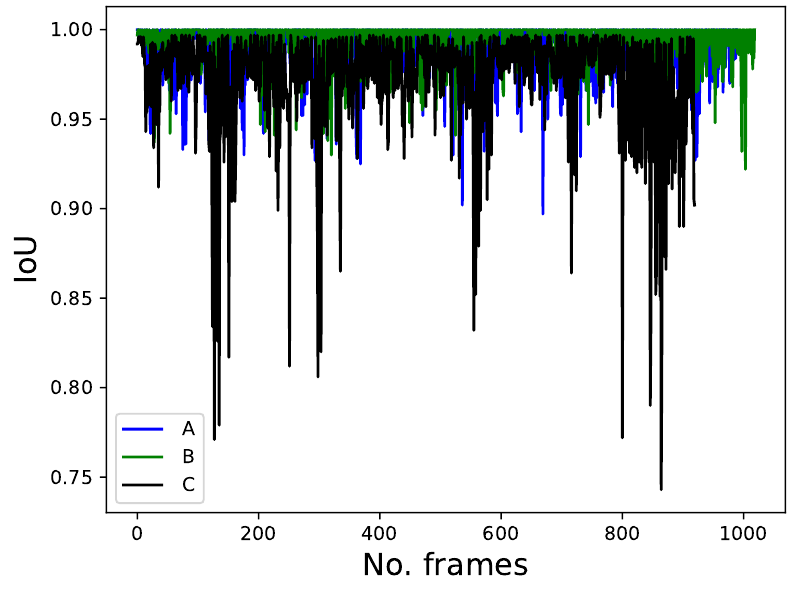
Figure 11. IoU feature. Figure 12a–c depict the localization, localization difference, and normalization of the localization difference of the target person over all the frames, respectively. As aforemen- tioned, the horizontal FOV of the camera was 60 ◦ .